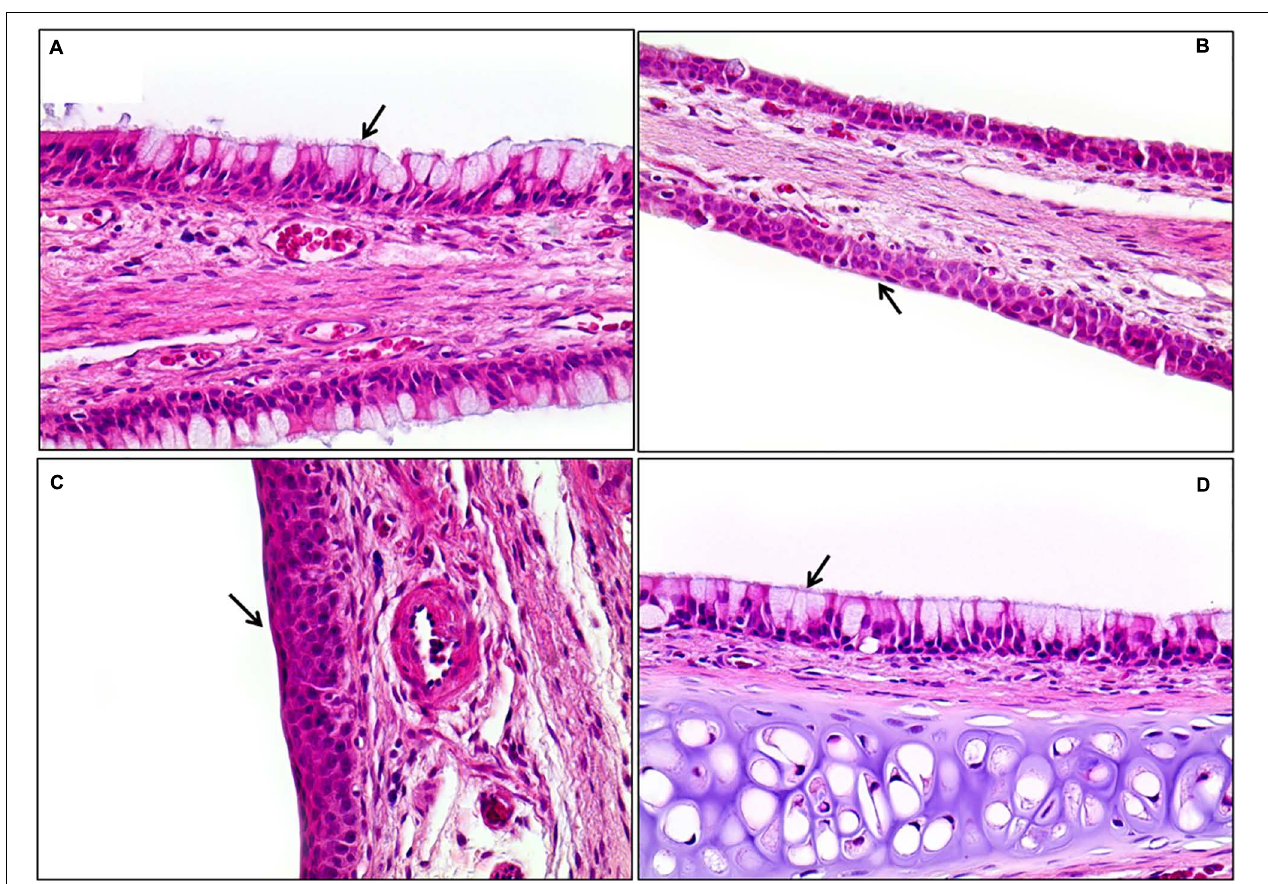
FIGURE 13 | Histopathological staining of the nasal cavity in the male rats exposed to the mixture of SM and PG for 2 weeks by aerosol inhalation. Panels (A–C) are the results of exposure groups each defining for control, medium-, and high-dosage treatment, respectively. Panel (D) shows the recovery of high-exposure groups. Note the metaplasia of the respiratory epithelium into squamous cells in (B) and (C) (arrows). Compare these with normal respiratory epithelium composed of ciliated pseudostratified columnar epithelium with goblet cells [arrows in (A) and (D) ]. Squamous cell metaplasia occurred in the front of the nasal cavity, but was completely recovered 7 days after exposure was stopped (D) . H&E staining. Magnification = × 400 for all